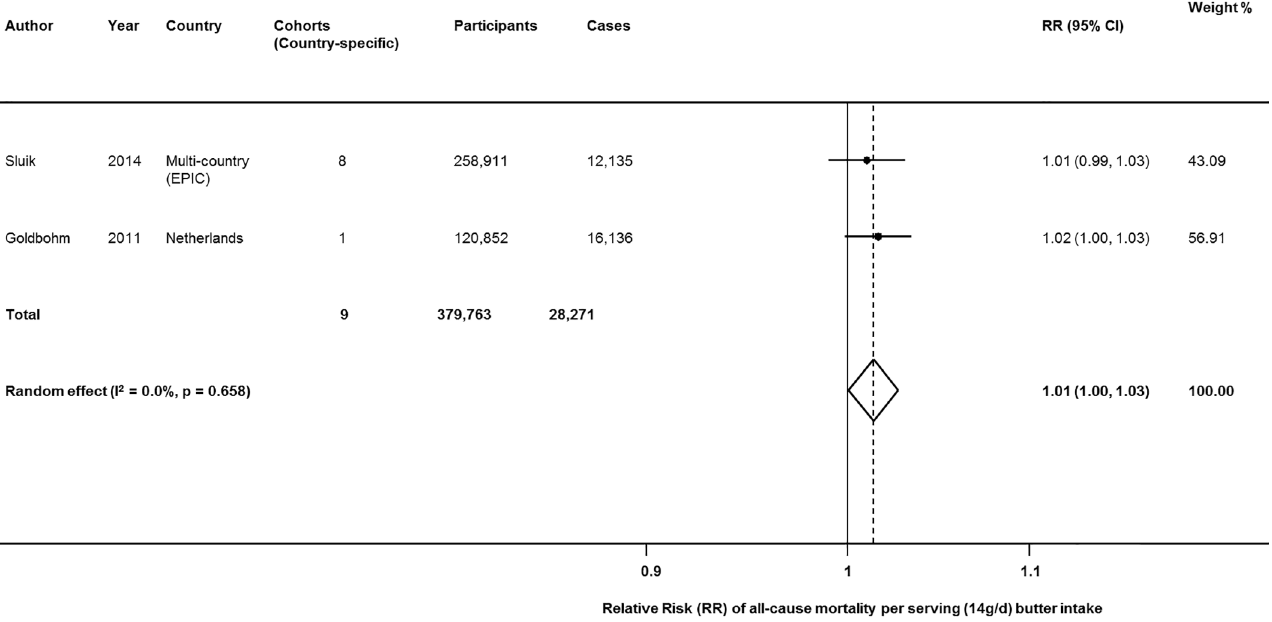
Fig 2. Butter consumption and risk of all-cause mortality. Within-study dose-response RRs were derived from reported linear effects or generalized least-squares trend estimation for studies reporting categories of intake, and pooled using both inverse-variance weighted random and fixed effects meta-analysis.